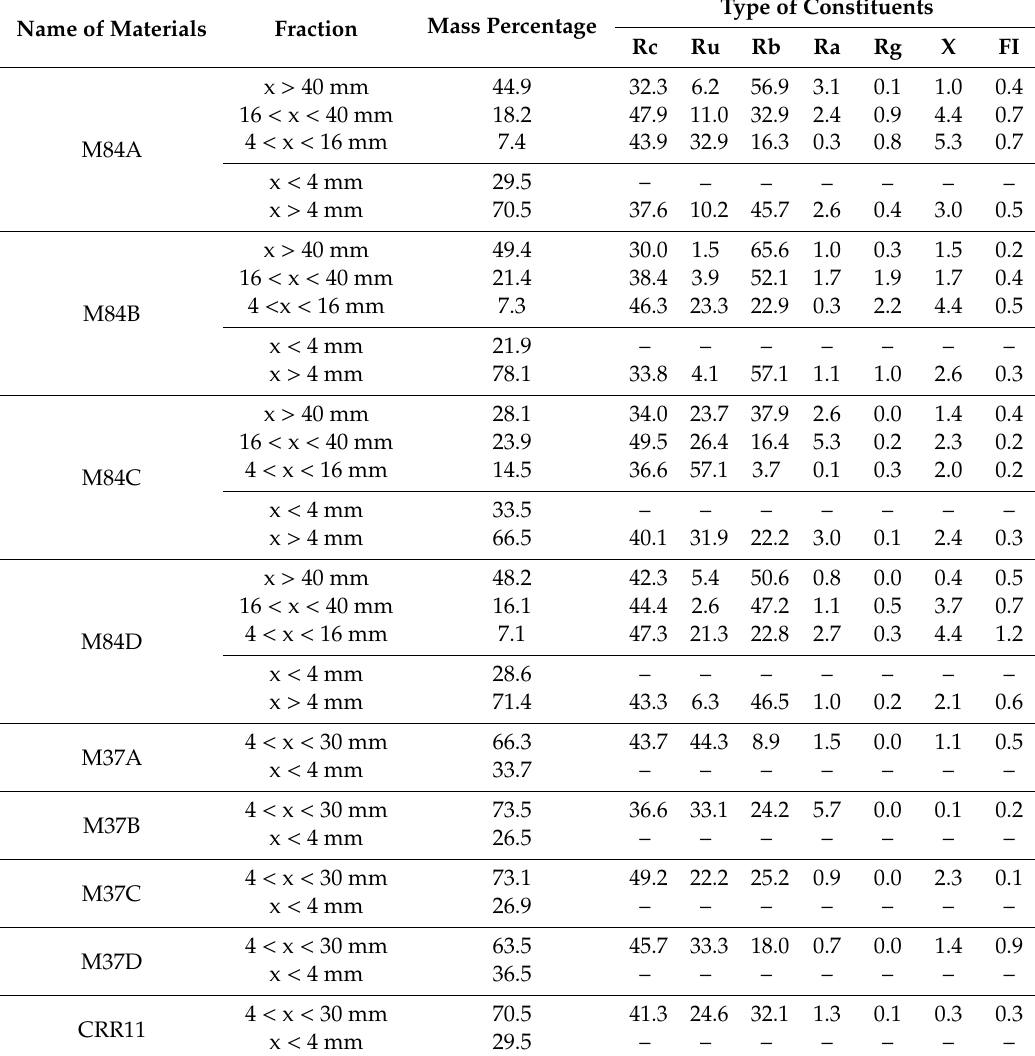
Table 3. Classification of raw materials (M84A to D) and recycled materials after treatment (M37A to D) according to EN 933-11 (Rc, Ru, Rb, Ra, Rg, X and FI refer to percentages of concrete products, unbound aggregate, clay masonry units, bituminous materials, glass, other non-floating materials and volume percentage of floating material in %,